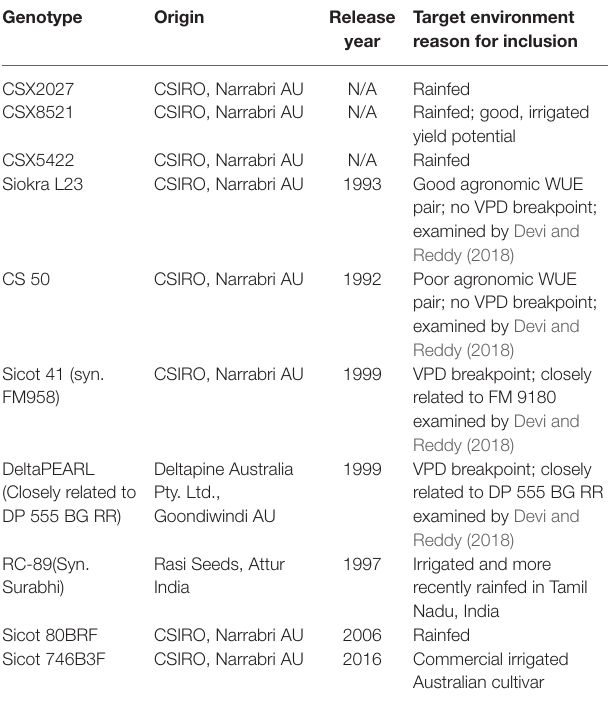
TABLE 1 | Genotypes used in this study, including details on origin, release year and target environment.